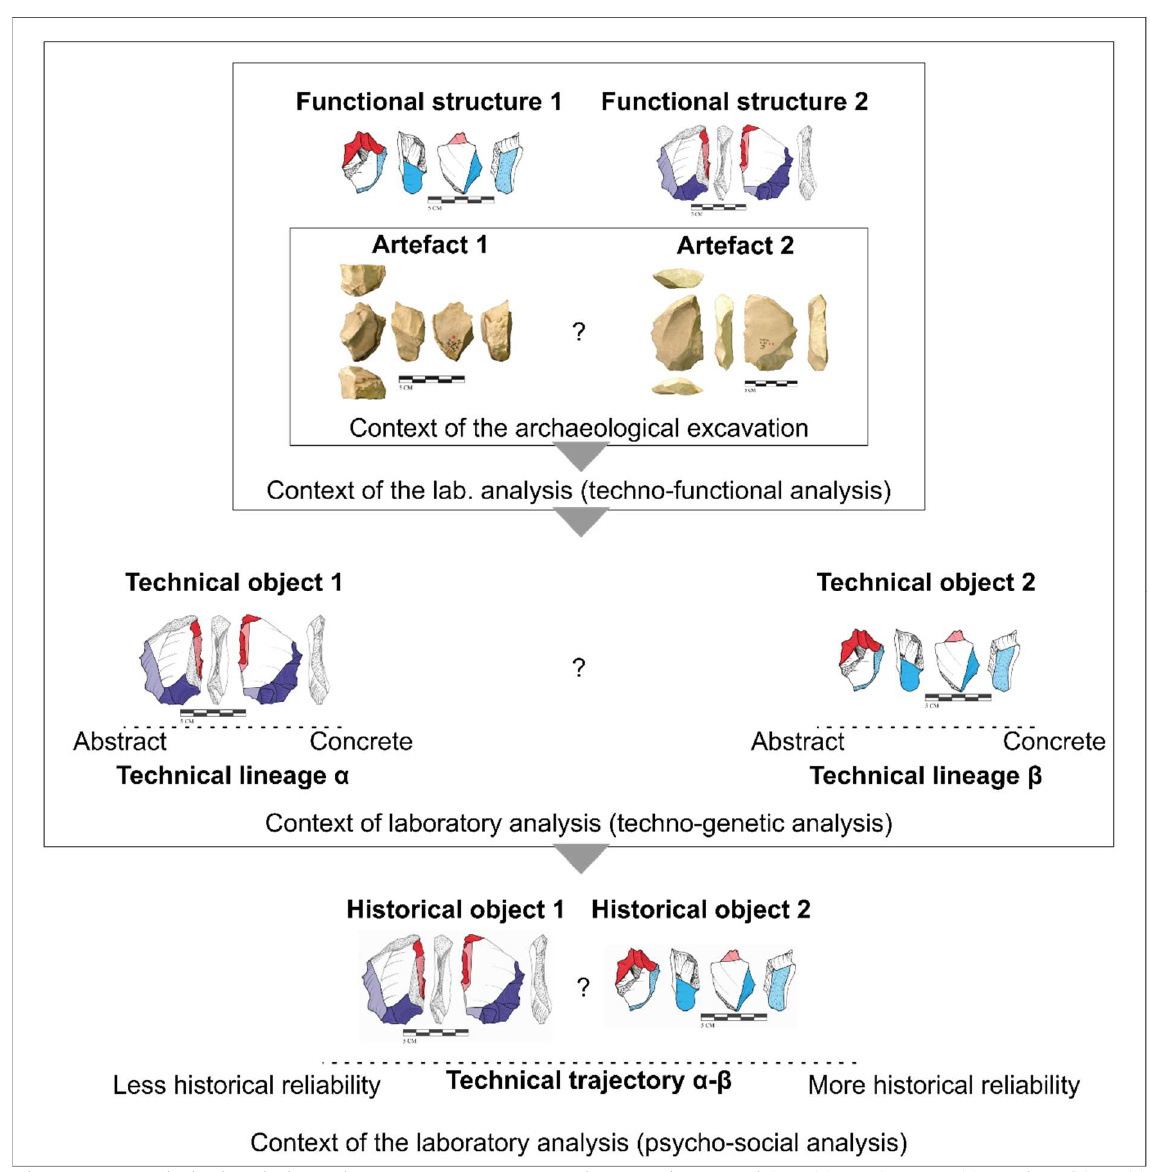
Figure 2. Technical relations between structures and operations, schéma(s) opératoire(s) and schème(s) opératoire(s) , in prehistoric